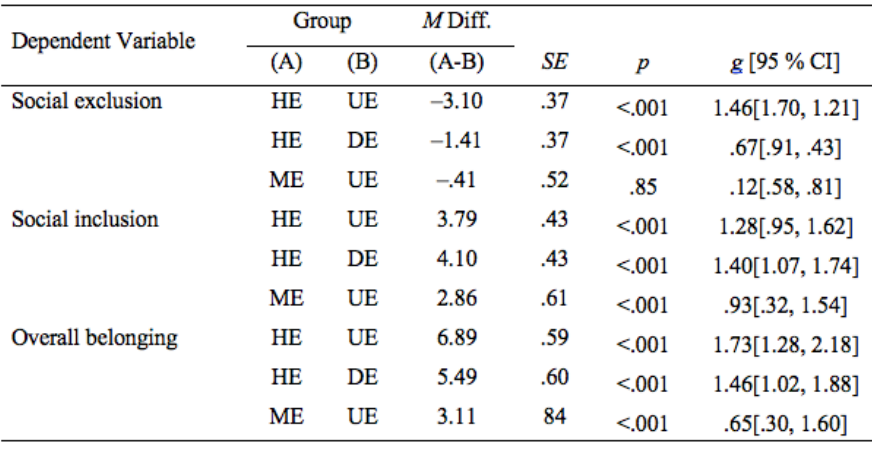
Comparisons results for bidimensional emotional health